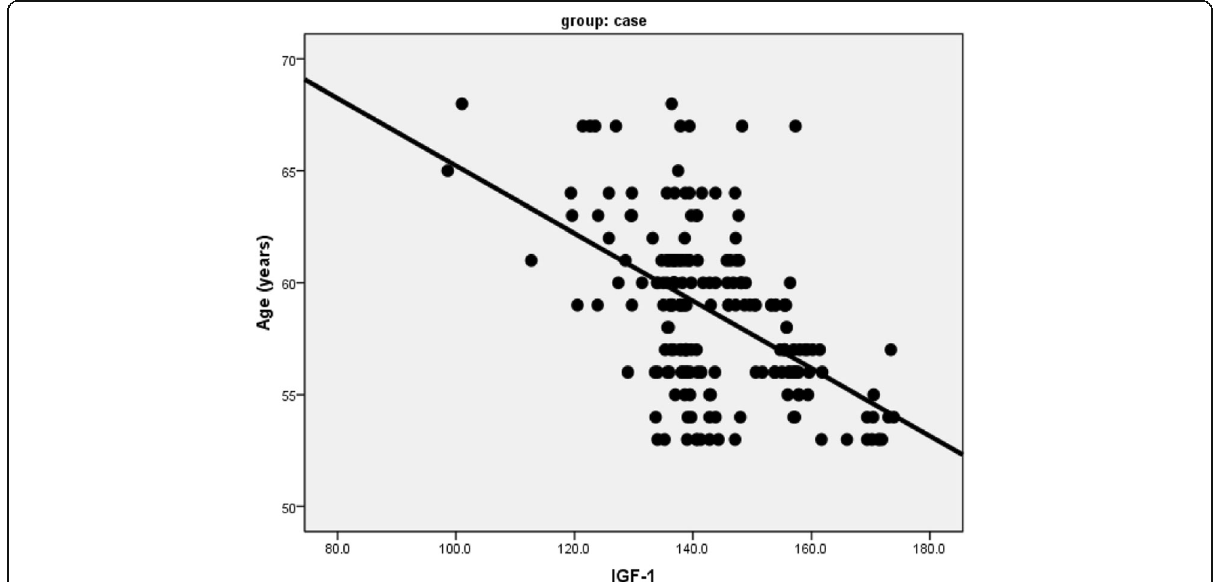
Fig. 1 Correlation between IGF-1 and age of patients. IGF-1, insulin growth